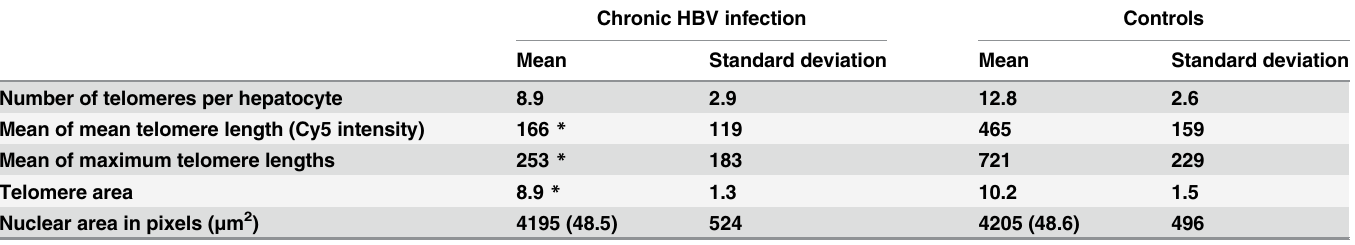
Fig 2 is a representative example of hepatocyte staining in chronic HBV. Comparison was made with 55 age and sex matched sections control. Overall, the mean number of telomeres de- tected per hepatocyte was similar in chronic HBV infection and controls (Table 1). However, Table 1. Q-FISH analysis of